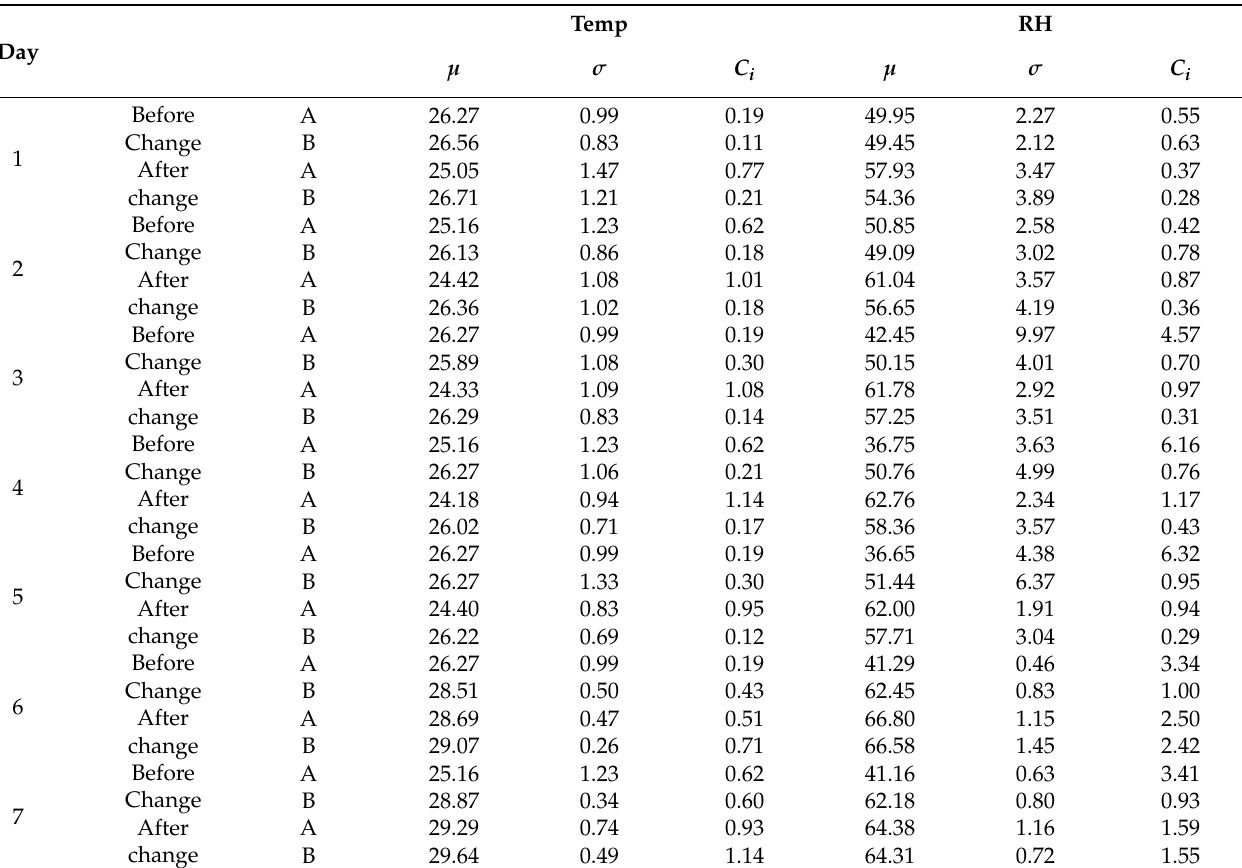
Table 2. Comparison of environmental performance indicators before and after the implementation of the improvement plan.